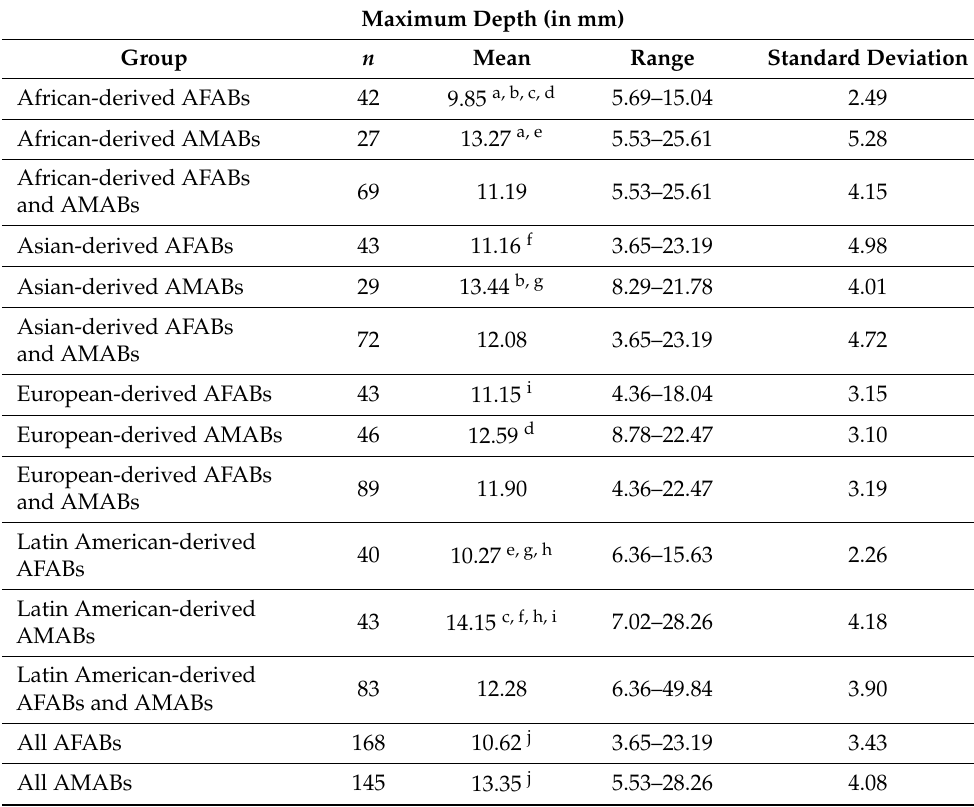
Table 7. Descriptive statistics for the frontal sinus maximum depth by population affinity and assigned